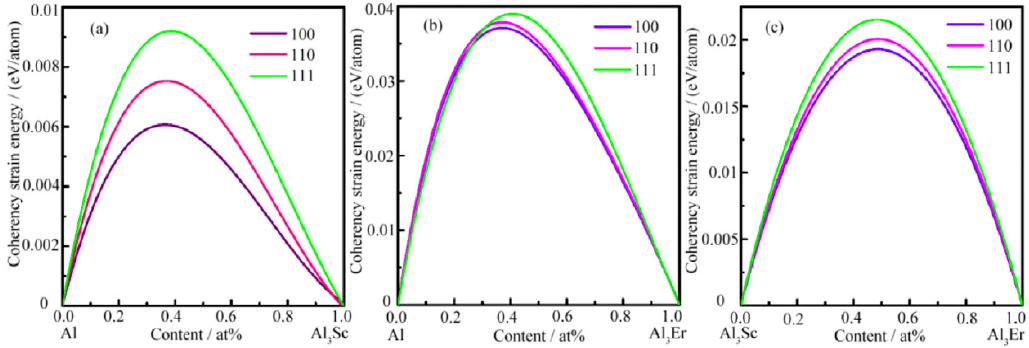
Figure 16. Coherency strain energies of ( a ) Al/Al 3 Sc, ( b ) Al/Al 3 Er, ( c ) Al 3 Sc/Al 3 Er on (100), (110),